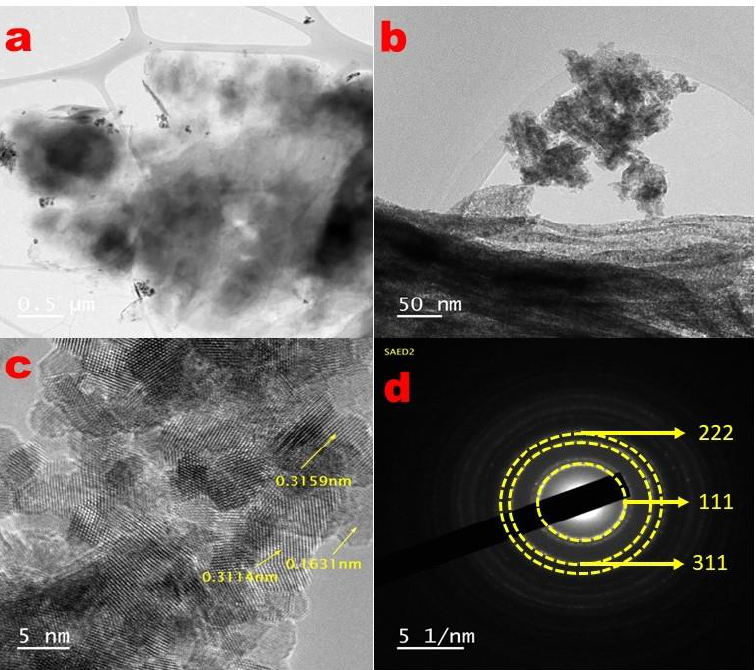
Figure 4. TEM images of the CeO 2 –GO-3 electrocatalyst at ( a ) low and ( b ) high resolutions; ( c ) HR- TEM; and ( d ) SAED pattern.